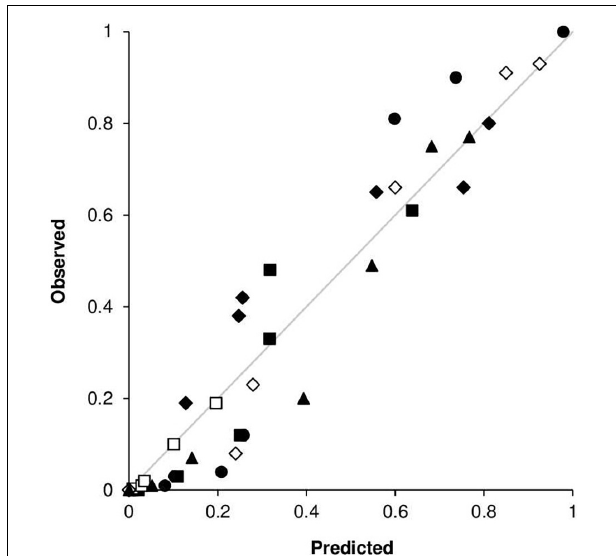
FIGURE 11 | Predicted versus observed values of stem rust severity in the following locations and years: ( • ) Rosemount, MN, United States, in 1968; ( (cid:4) ) Rosemount, MN, United States, in 1978; ( (cid:3) ) Rosemount, MN, United States, in 1979; ( (cid:7) ) St. Paul, MN, United States, in 1978; ( ♦ ) St. Paul, MN, United States, in 1979; and ( (cid:78) ) Rock Springs, PA, United States, in